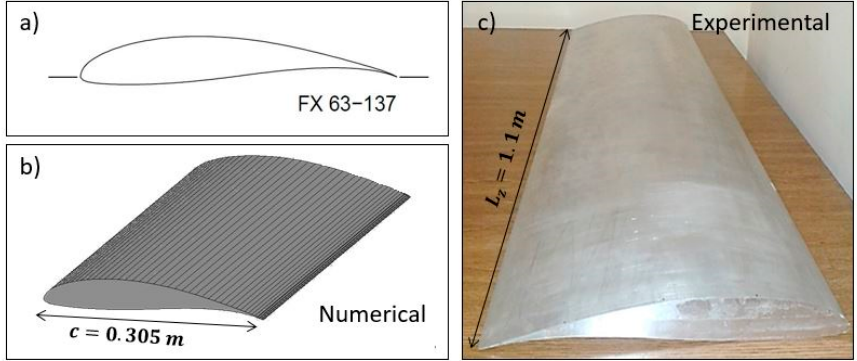
Figure 1. Airfoil FX 63-137. ( a ) 2D section. ( b ) 3D numerical blade. ( c ) Experimental model.